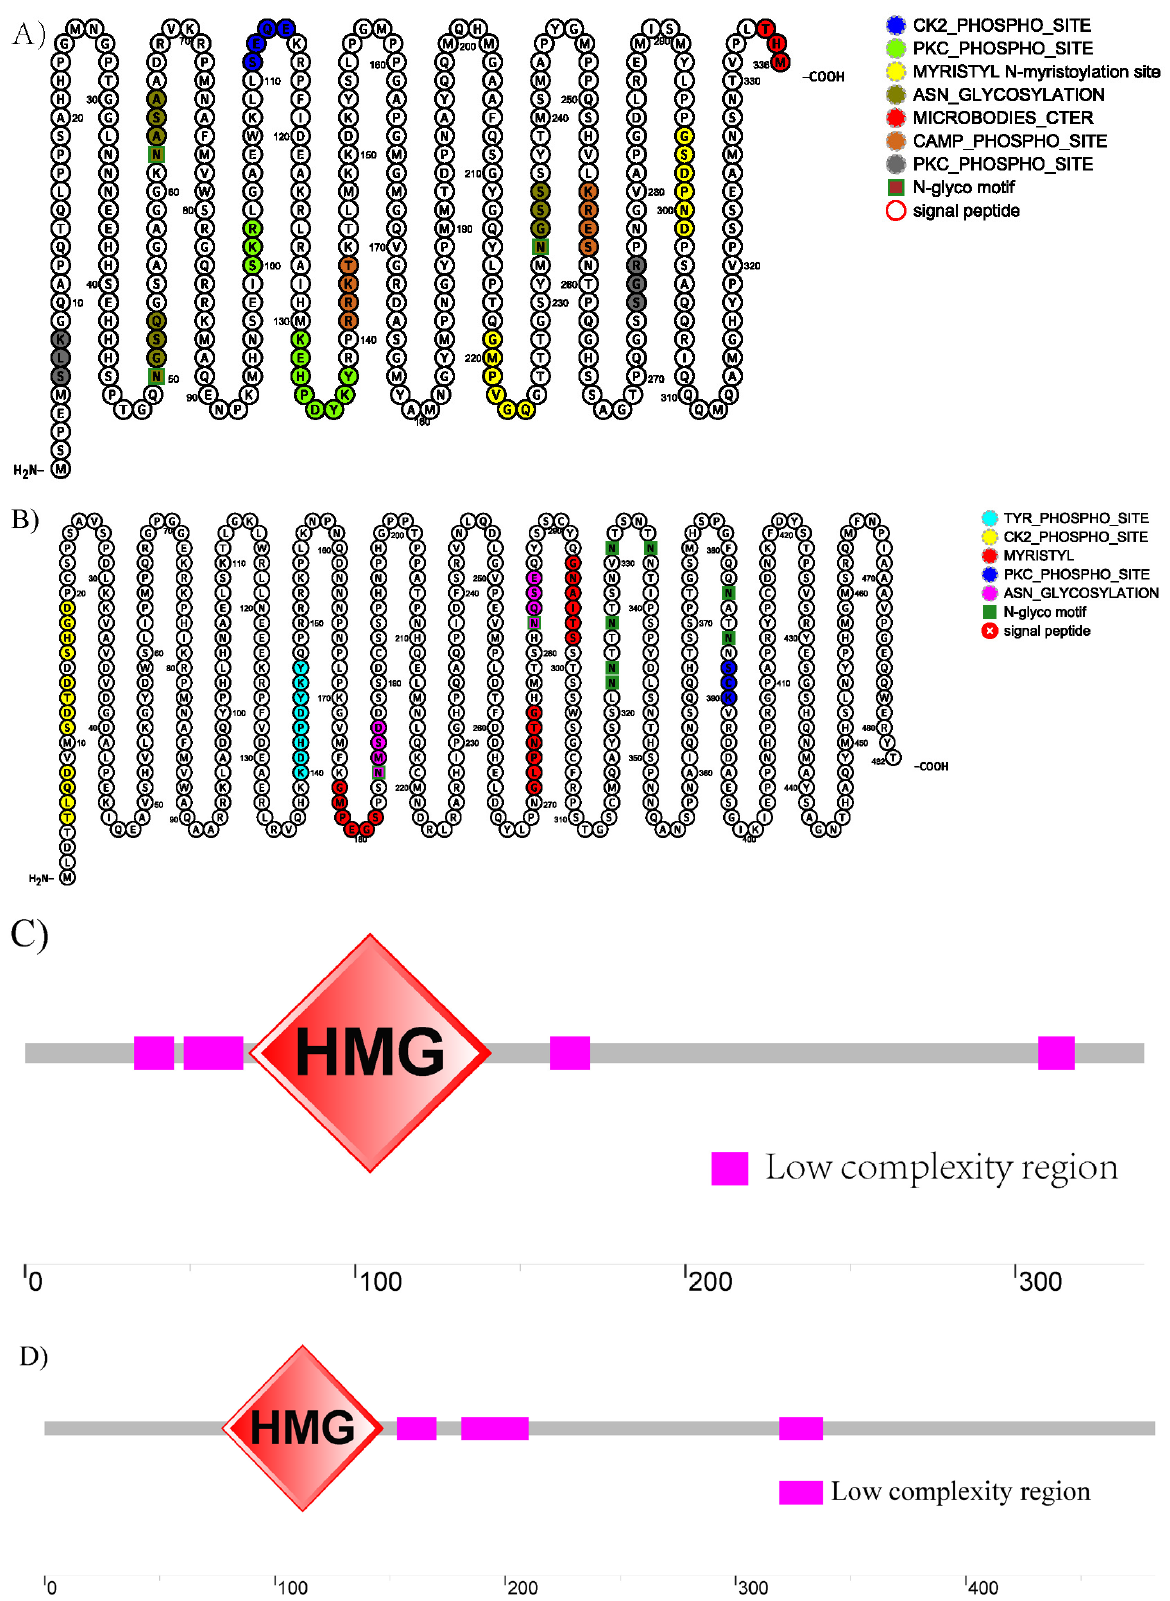
Figure 3. Sequence analysis of LsSox 2 and LsSox 9. ( A ) LsSox 2 motif sites. ( B ) LsSox 2 protein domain structures. ( C ) LsSox 9 motif sites. ( D ) LsSox 9 protein domain structures.